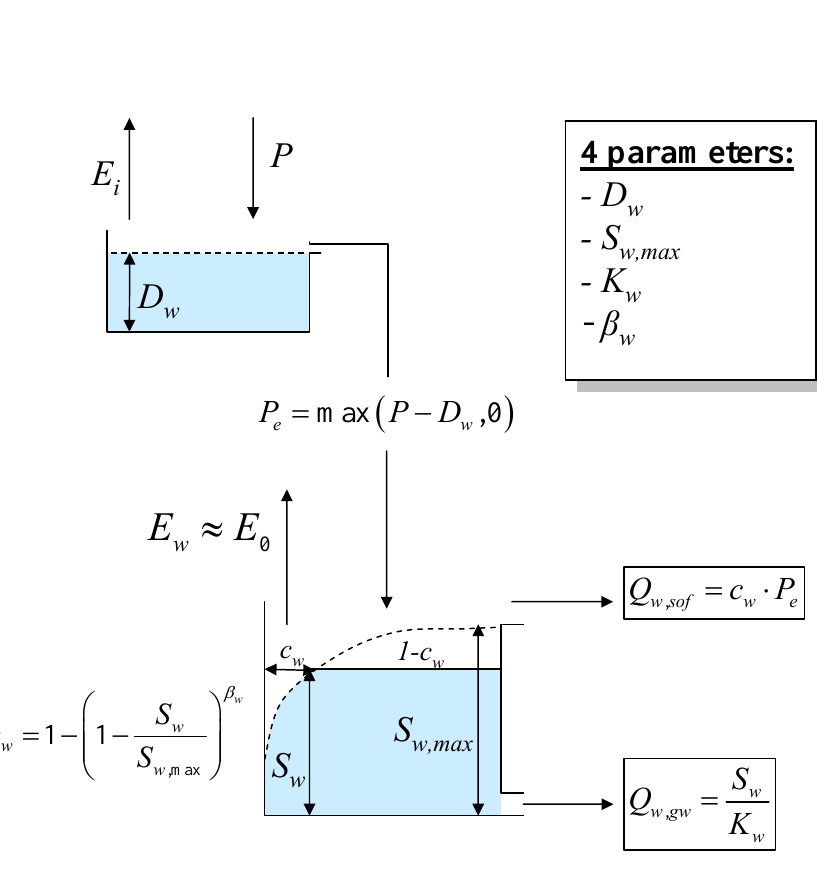
Fig. 2. Wetland conceptual